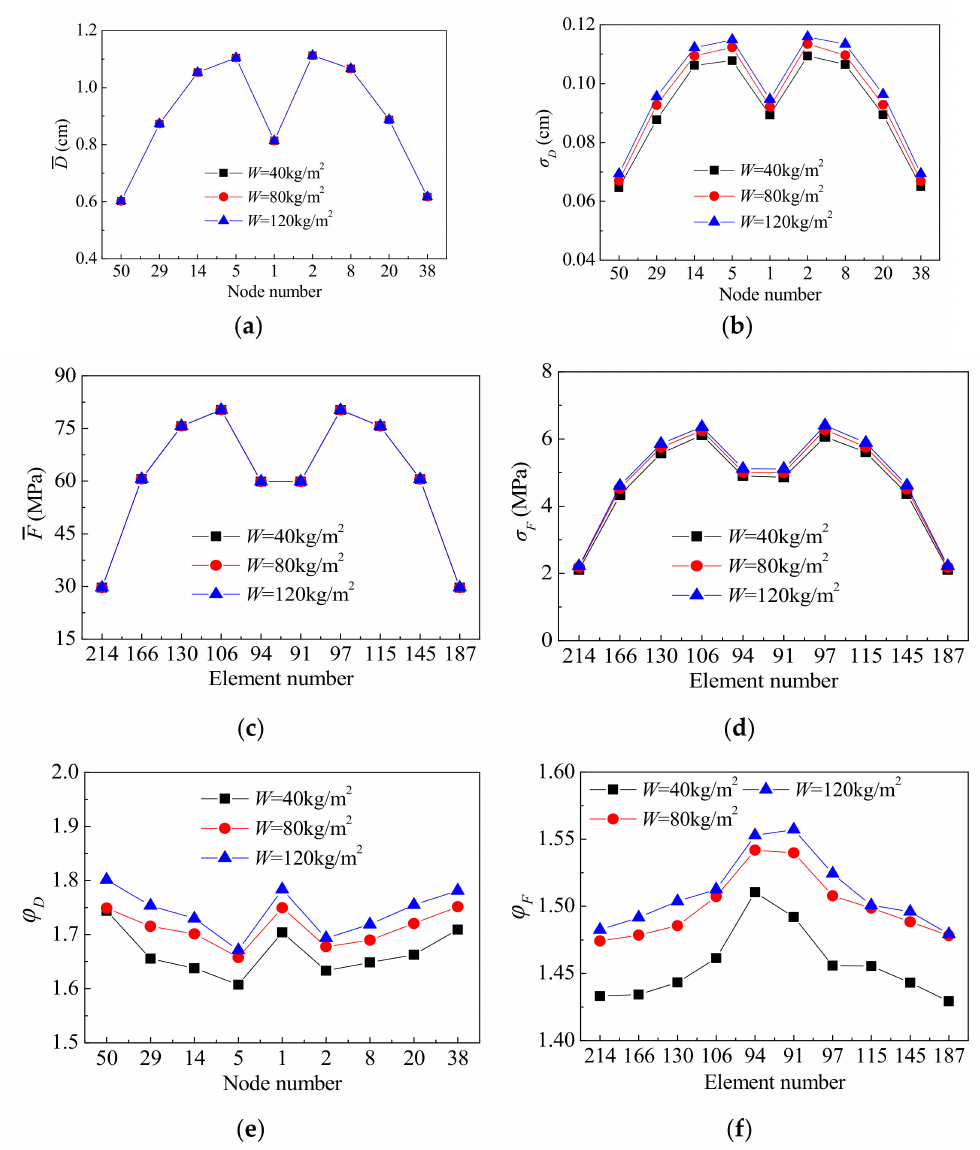
Figure 7. Structural responses versus different roof masses: ( a ) mean displacements of nodes; ( b ) mean square displacements of nodes; ( c ) mean internal forces of elements; ( d ) mean square internal forces of elements; ( e ) DVCs of nodal displacement; ( f ) DVCs of elemental internal